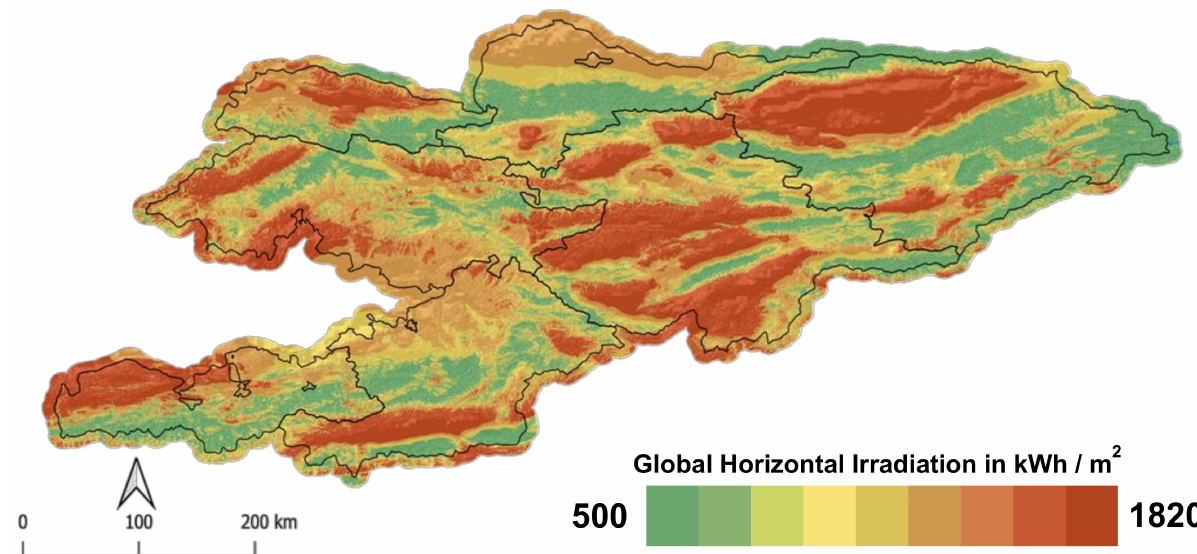
Figure 2. Global Horizontal Irradiation of Kyrgyzstan (own illustration based on